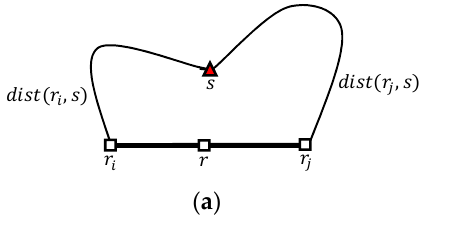
Figure 6. Computation of the distance from